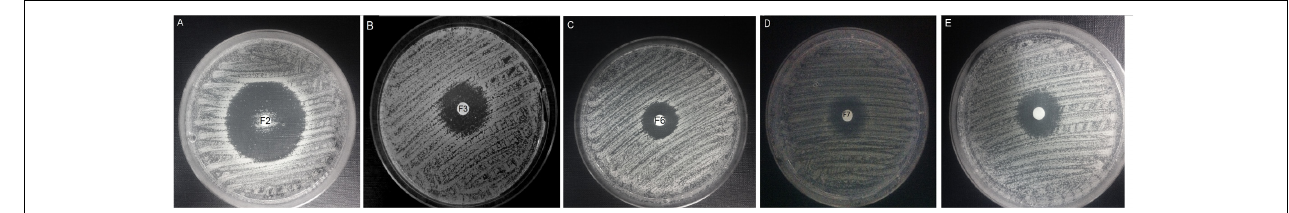
FIGURE 3 | Disc diffusion activity determination of FMDP-oligopeptides. YNB-AS agar medium, 10 µ g of each peptide applied on a disc. (A) F2; (B) F3; (C) F6; (D) F7; (E) F11.